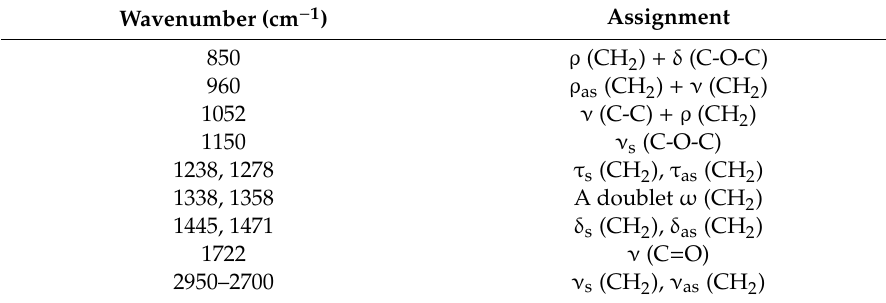
Table 3. Wavenumbers and assignments of IR bands exhibited by samples 5 and 12. Where, ν = stretch, δ = scissor/deformation, ω = wag, ρ = rock, τ = twist. The subscripts s and as refer to symmetric and asymmetric vibrational modes, respectively.